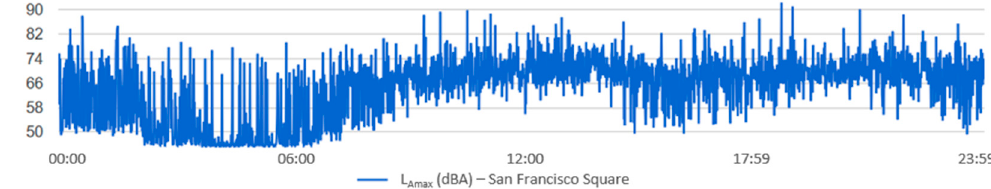
Figure 14. The L Amax measured at each 30-s interval from 00:00 to 23:59 on 30 June 2017 in San Francisco Square.